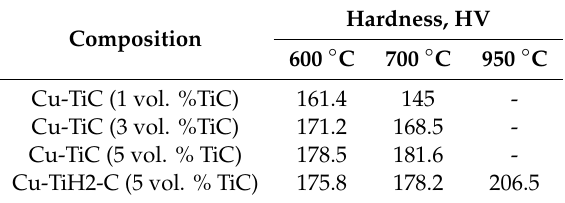
Table 3. Hardness values of composites sintered at di ff erent temperatures.